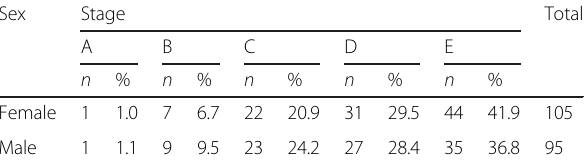
Chi-square test: P =0.898, not